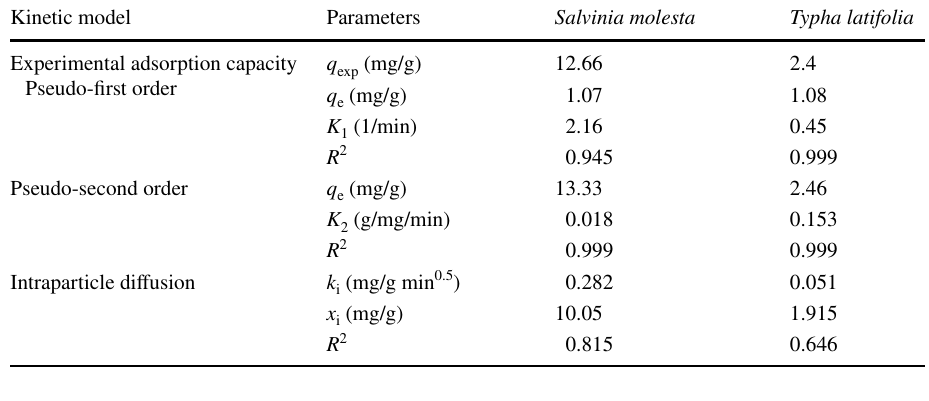
Fig. 14 Pseudo-second-order kinetic plot for Cr 6+ adsorption on S. molesta and T.